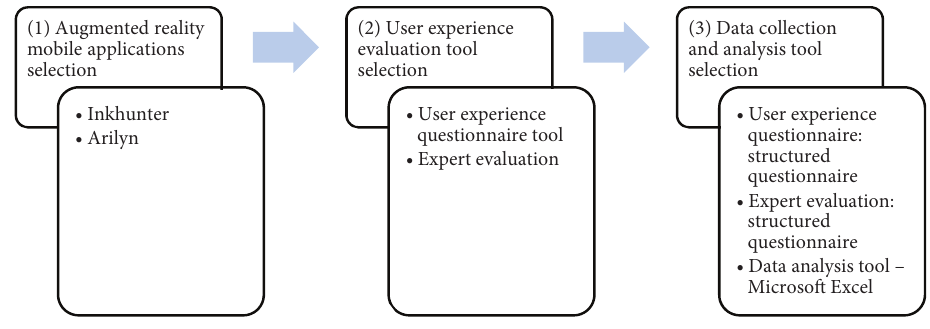
Figure 1. Research process structure (source: created by the authors) Table 2. Summary of augmented reality applications Inkhunter and Arilyn (source: created by the authors)